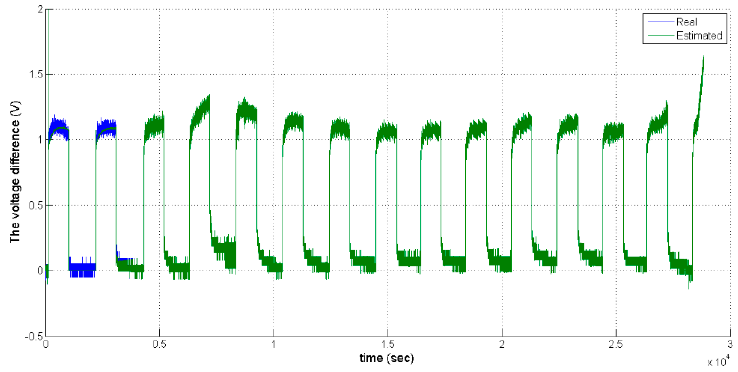
Figure 11. The parameter estimation using multiple forgetting factors.